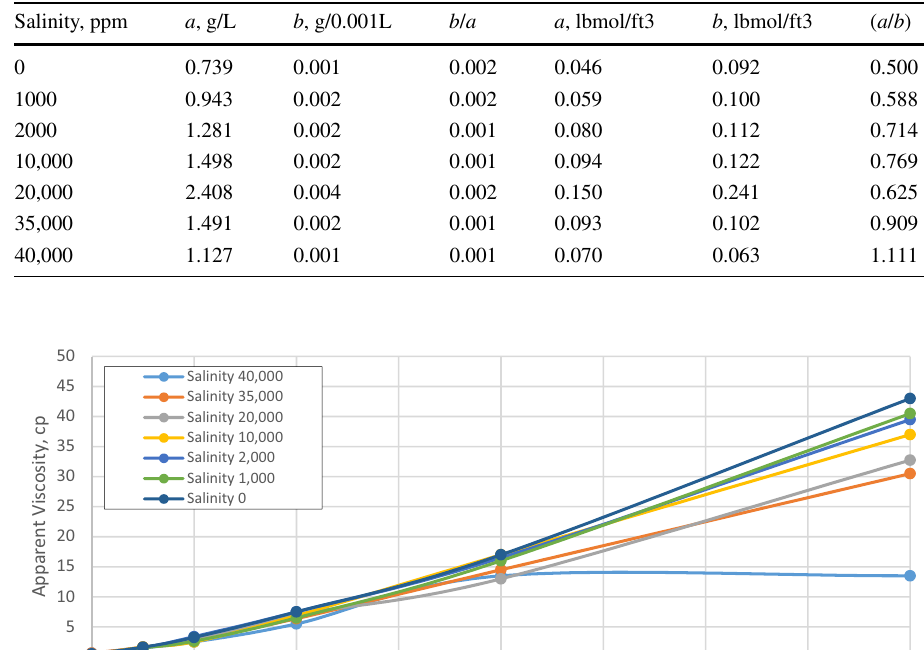
Polymer Concentra(cid:3)on, ppm